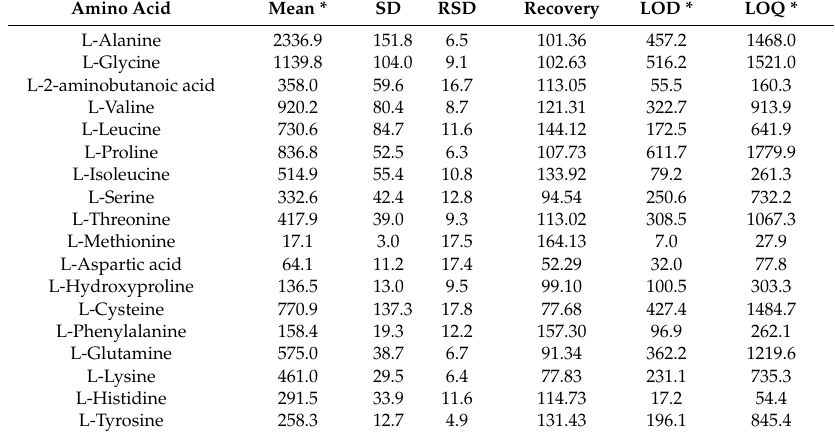
Table 4. Repeatability, recovery, LOD (limits of detection), and LOQ (limits of quantitation) of amino acids analysis in Iberian dry-cured ham by GC–FID.